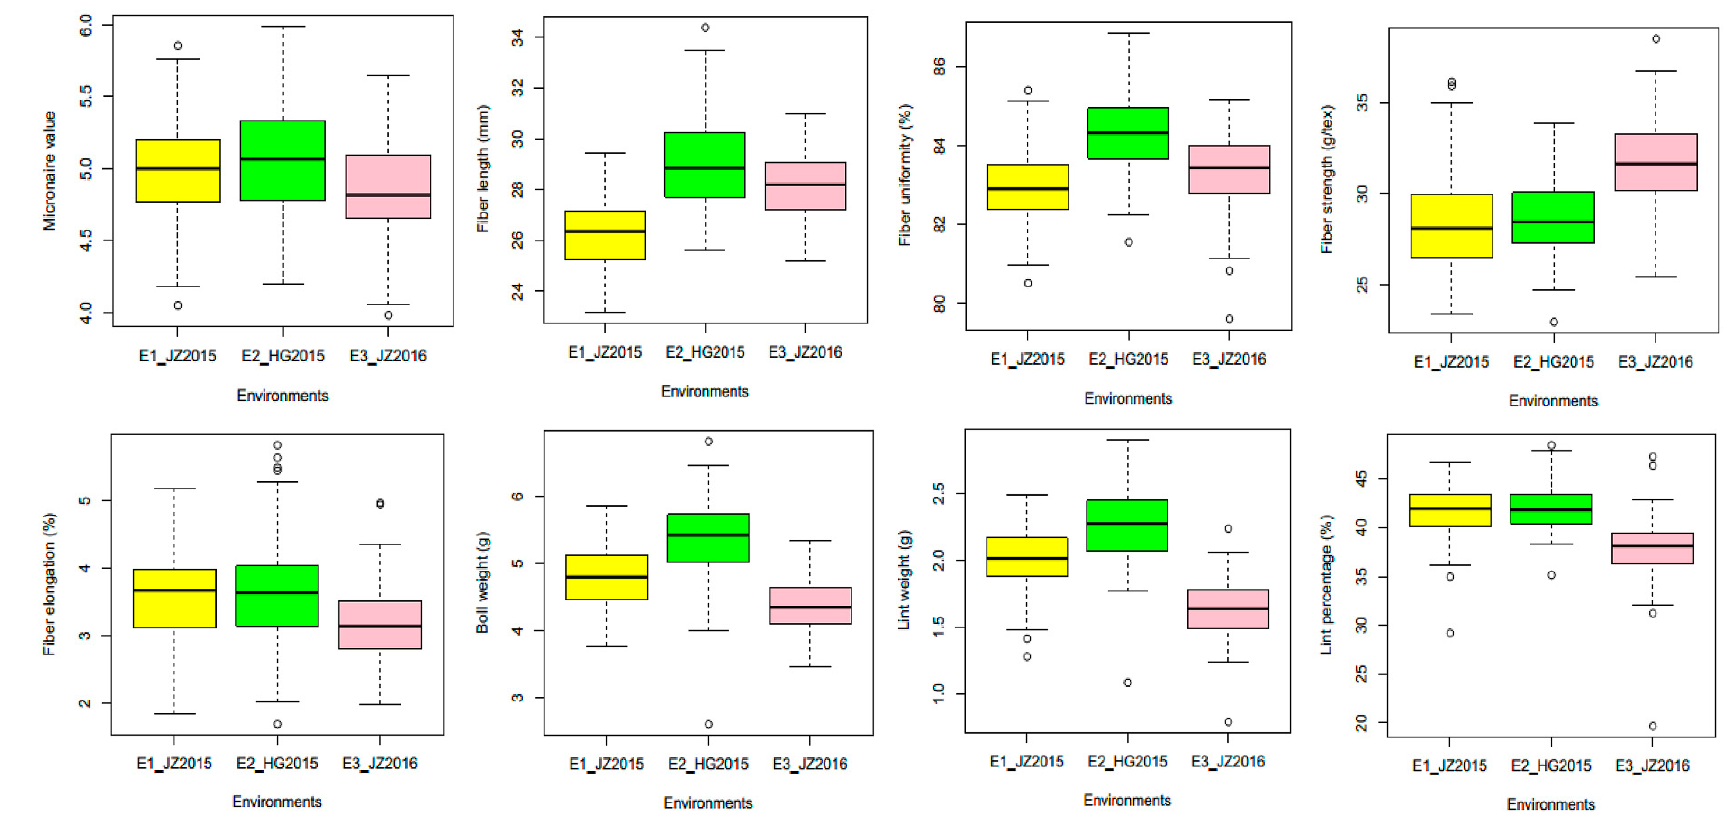
Figure 2. Box plot of the changing trends of fiber quality and yield traits in three environments (HSW, PH, and BN are displayed in the supplementary file; FBN and SI that were only in E3 were not analyzed). Data collected from E1_JZ2015 (ILs planted at Jinzhou in year 2015), E2_HG2015 (at Huanggang in year 2015) and E3_JZ2016 (at Jinzhou in year 2016) are presented, while the circles represent outliers.